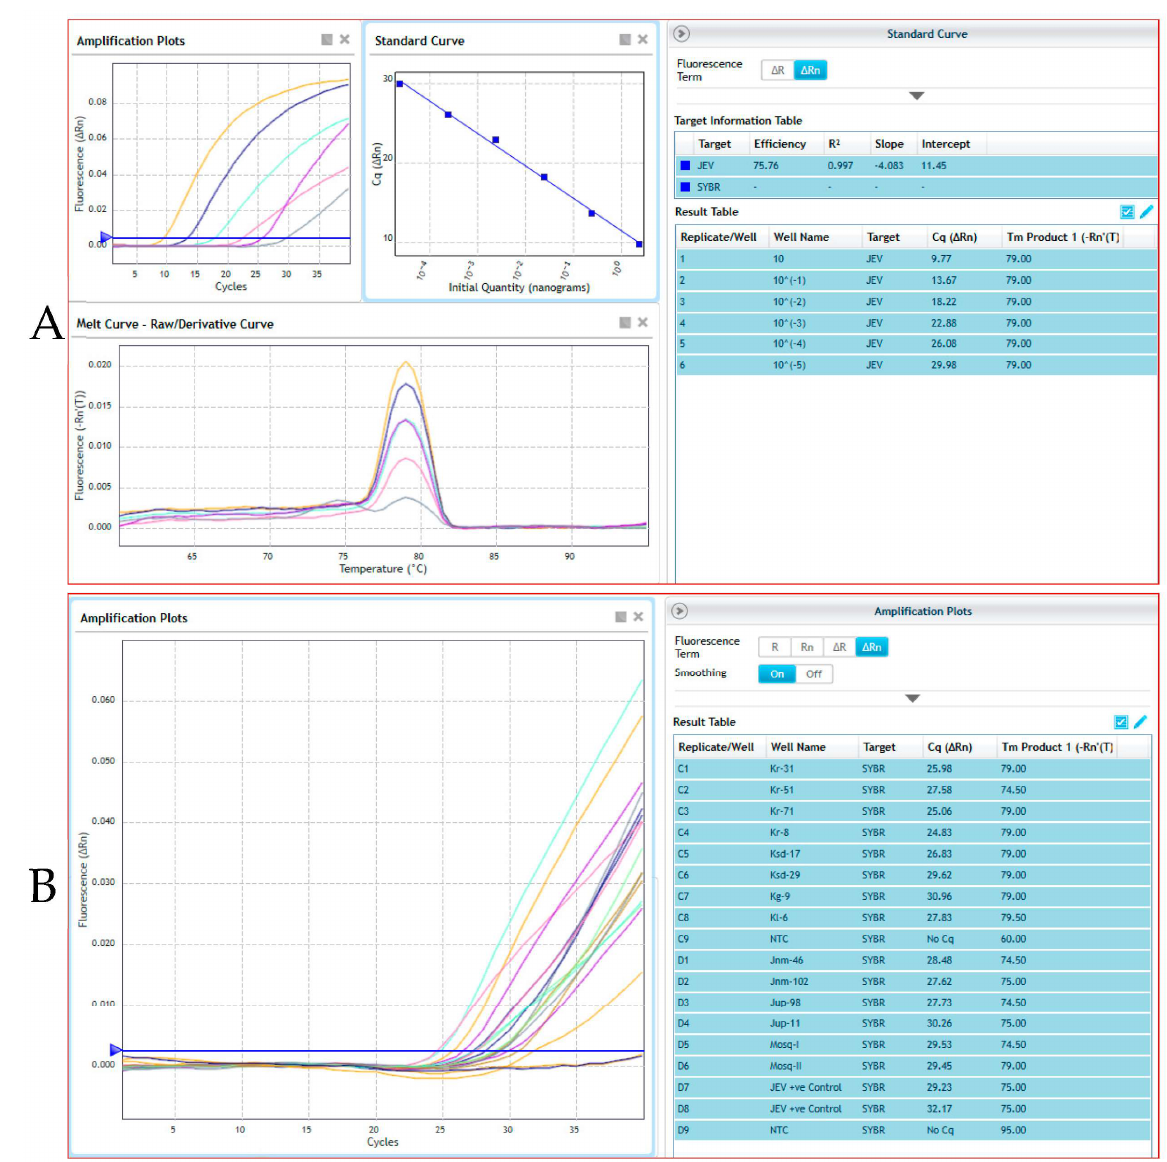
Figure 3. Real time PCR for detection of Japanese encephalitis virus (JEV) from different pig and mosquito samples. Here, ( A ) shows the standard curve analysis of a representative JEV positive control sample, where 10-fold dilution factor of the sample represents 75.76% of efficiency upto 6th dilution (10 − 5 ); ( B ) shows the presence of JEV in representative test pig and mosquito samples. These indicated that the positive samples were contains JEV cDNA/RNA in each respective reaction. The 6th (well-D7) and 7th (well-D8) dilution of samples were used as representative positive control for detection of JEV concentration in the present